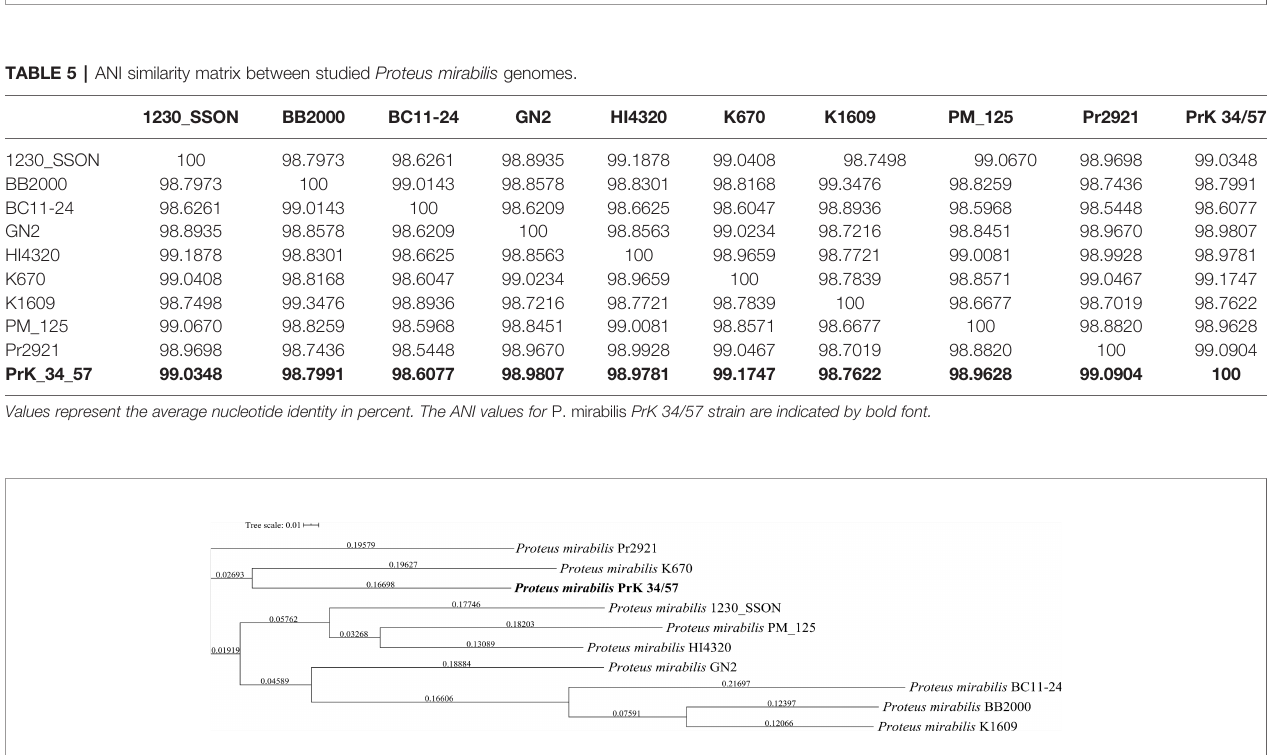
FIGURE 1 | KEGG pathway analysis of Proteus mirabilis PrK 34/57 strain. Proteins were identi fi ed and categorized using the GhostKOALA tool against the Amino-Acid fi le generated by RAST server.